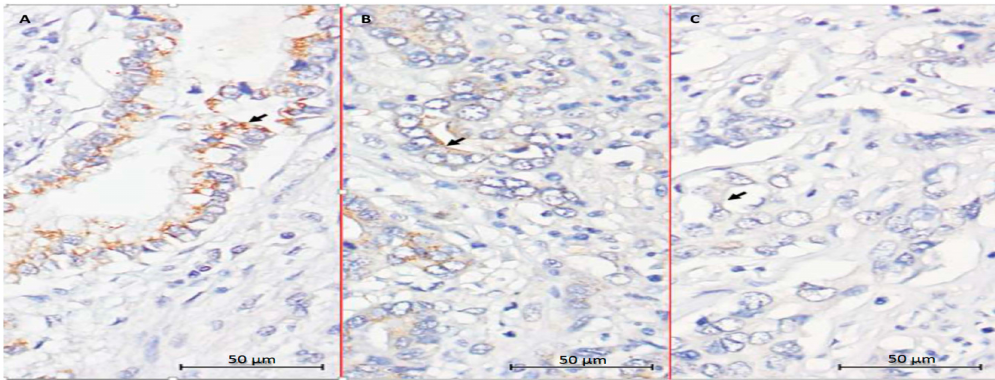
Figure 5. CYP27B1 expression in human CCA. Immunohistochemical staining of CYP27B1 in human CCA specimens with different intensity scores. ( A ) High expression; ( B ) Moderate expression; ( C ) Low expression; ( × 400, Scale bar = 50 µ m). ( Arrows indicate positive expression of